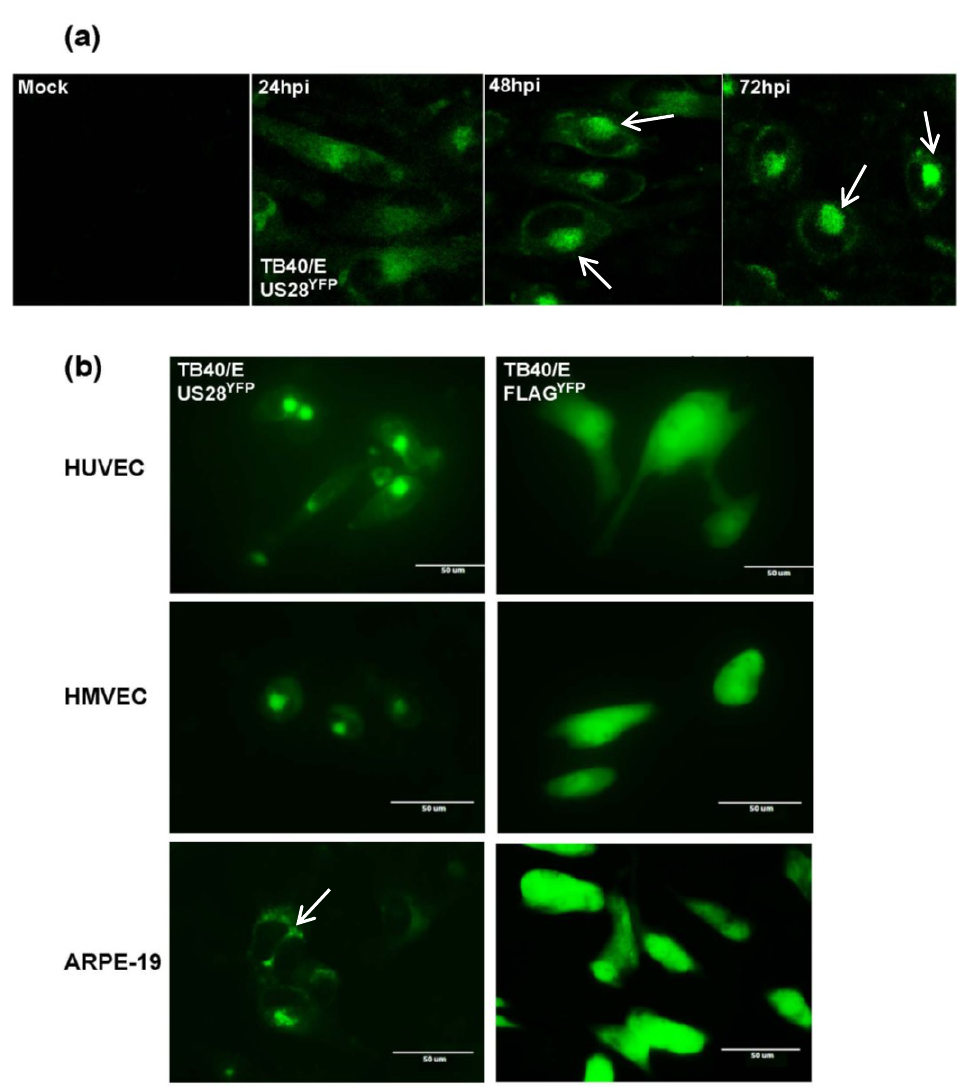
Figure 2. Formation of US28-expressing structures late during HCMV